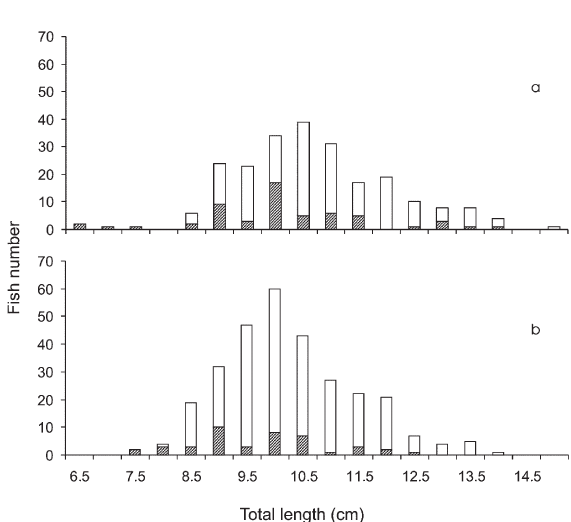
F ig . 3. – Numbers of dead (black) and surviving (white) brown F ig . 4. – Numbers of dead (black) and surviving (white) black goby combers ( Serranus hepatus ) in each length class for the combined ( Gobius niger ) in each length class for combined data in the open data of the open codend (a) and test (b) cages (four fish in the open codend (a) and test (b) cages (28 and 26 fish in the open codend and codend cage could not be measured). test cages respectively could not be measured).